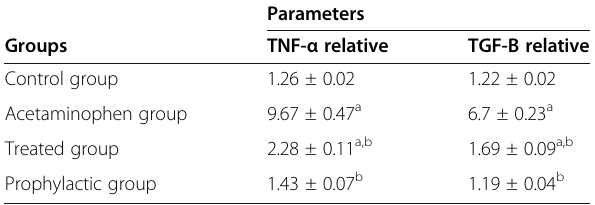
Table 3 Mean levels of liver function parameters in the different studied groups